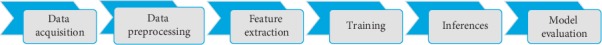
Flow diagram for machine learning-based model building.